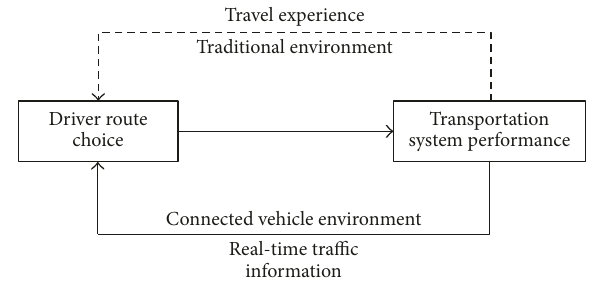
Figure 1: Dynamic feedback